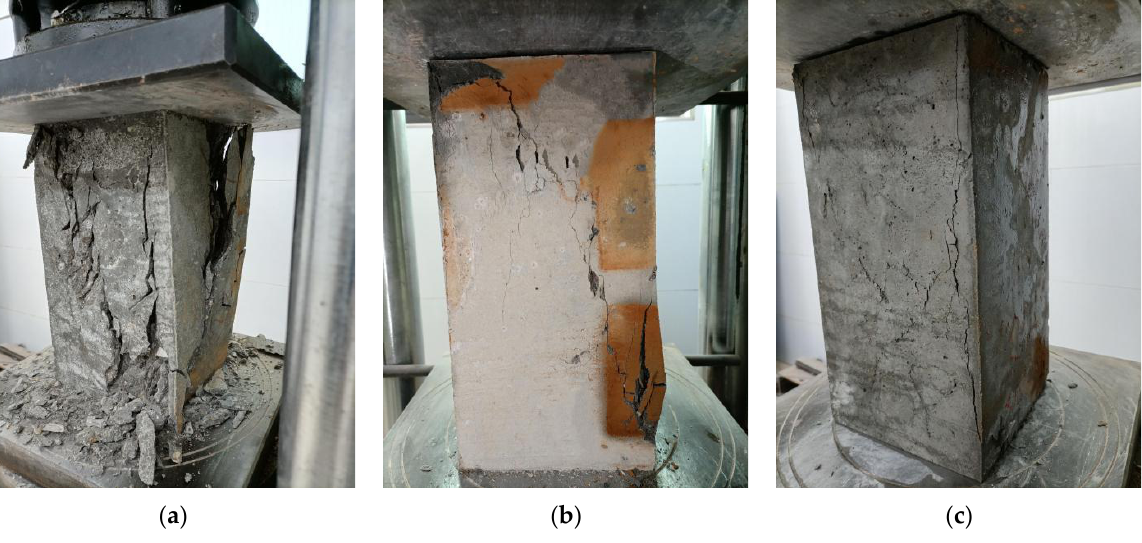
Figure 10. Failure modes in axial compression tests : ( a ) v sf = 0%; ( b ) v sf = 1%; ( c ) v sf = 2%.